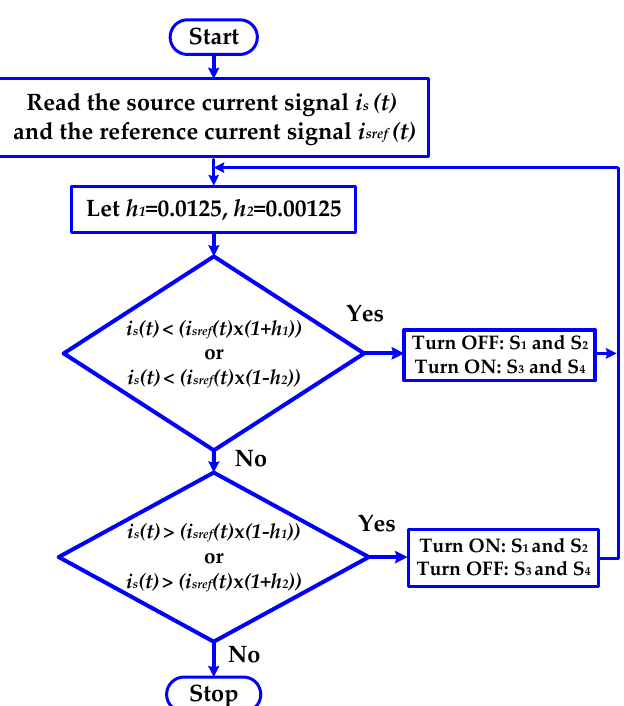
Figure 6. Detailed representation of the stage-2 MB-HCC algorithm.